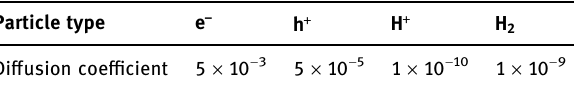
Table 1: Di ff usion coe ffi cient of movable particles in α - SiO